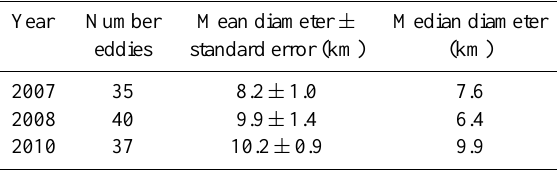
Table 2. Number of eddies per year at mooring #1, and their